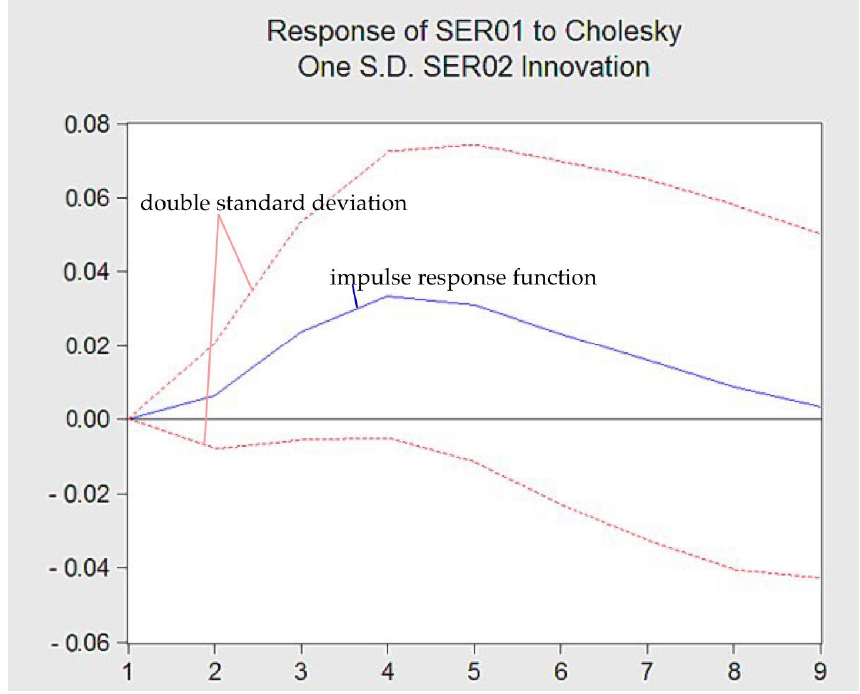
Figure 7. Impulse Response of carbon emissions to energy consumption.